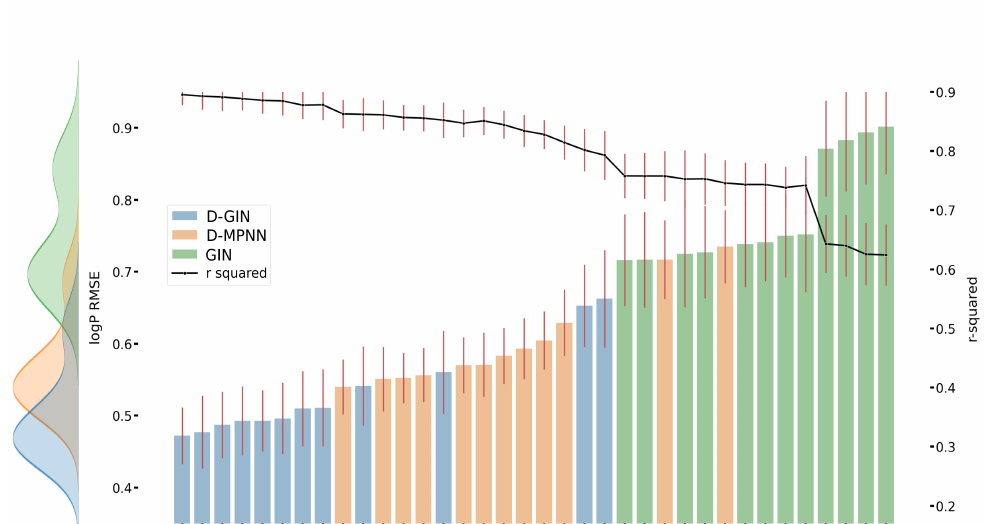
Figure 5. LogP prediction results for each GNN model instance. The left y-axis specifies the logP RMSE and the right, secondary x-axis the corresponding r 2 values for each GNN model. D-GIN is colored blue, D-MPNN orange, and GIN green. Each of the bars represent a different trained model-a detailed description can be found in Figure A2 in the Appendix A. The accumulated kernel density for each model type is shown on the very left side. The red lines correspond to the 95% confidence intervals. The model names are a combination of model type (D-GIN, GIN, D-MPNN), training approach and featurization type-a detailed description of each model name can be found in Tables A8–A19 in the Appendix